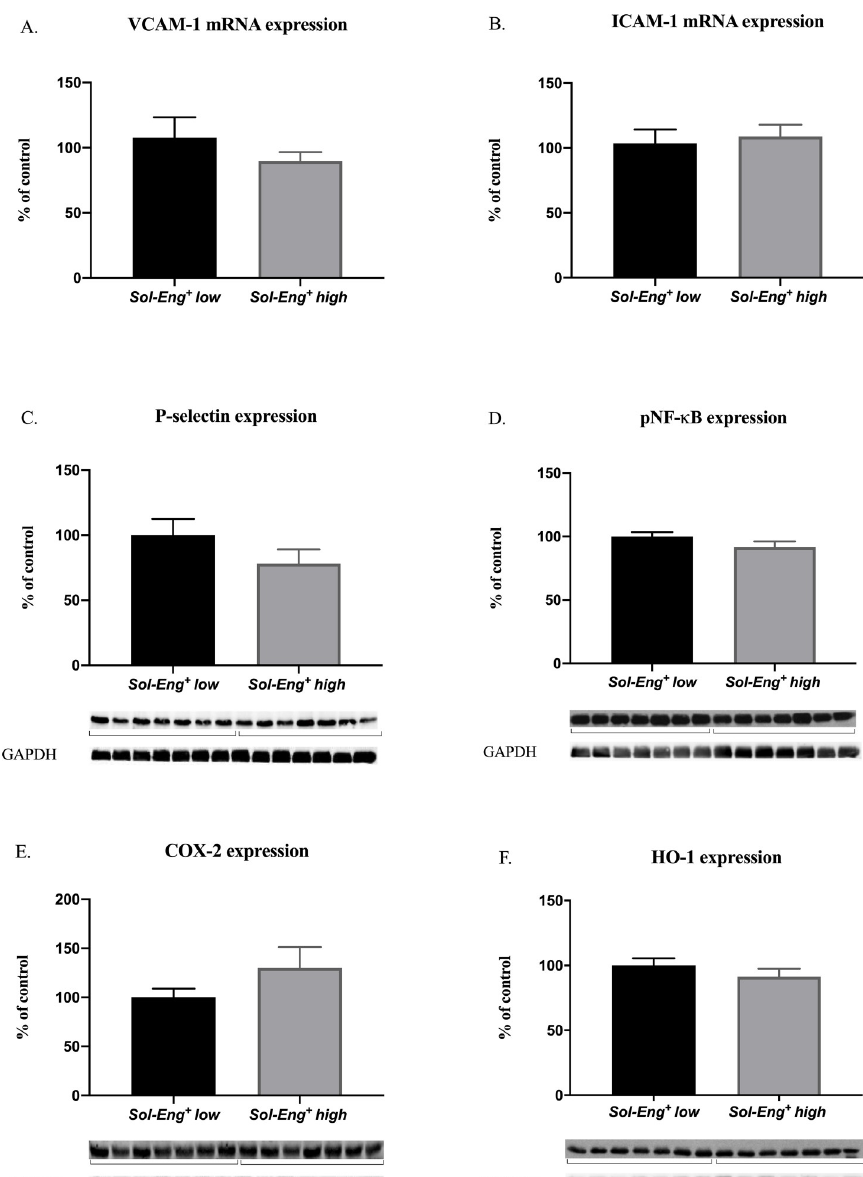
Fig 5. The expression of inflammatory markers in hearts of Sol-Eng + high and Sol-Eng + low mice. mRNA expression of VCAM-1 (A), ICAM-1 (B). The expression of P-selectin (C), pNF- κ B (D), COX-2 (E) and HO-1 (F) in total protein extracts from mice hearts. Top: densitometric analysis (control = 100%). Densitometric quantification of immunoreactive bands was recalculated to GAPDH signal. Bottom: representative immunoblots. Data are shown as mean ± S.E.M., Mann-Whitney test. n = 7 mice per